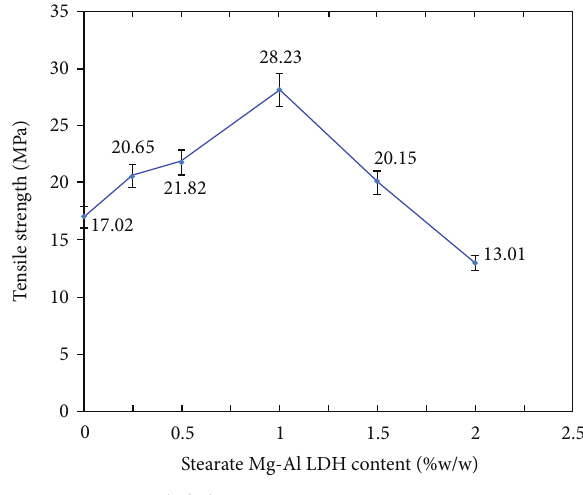
Figure 6: Tensile strength of PHB/PCL/stearate Mg-Al LDH nano- composites with 0.25, 0.5, 1, 1.5, and 2wt% stearate Mg-Al LDH